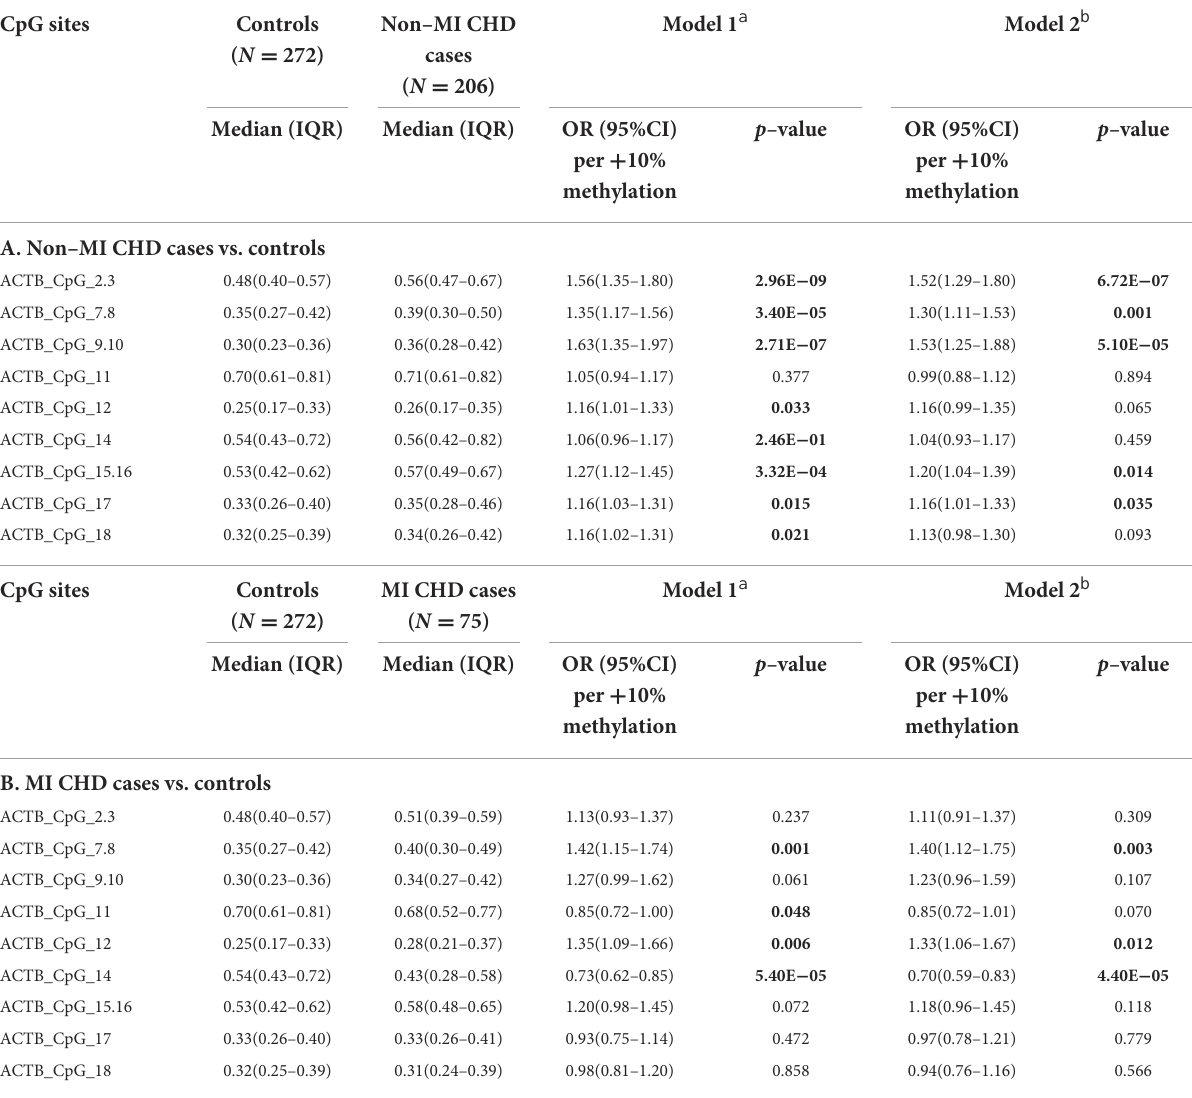
TABLE 5 Methylation difference of ACTB between non–MI CHD cases, MI CHD cases and